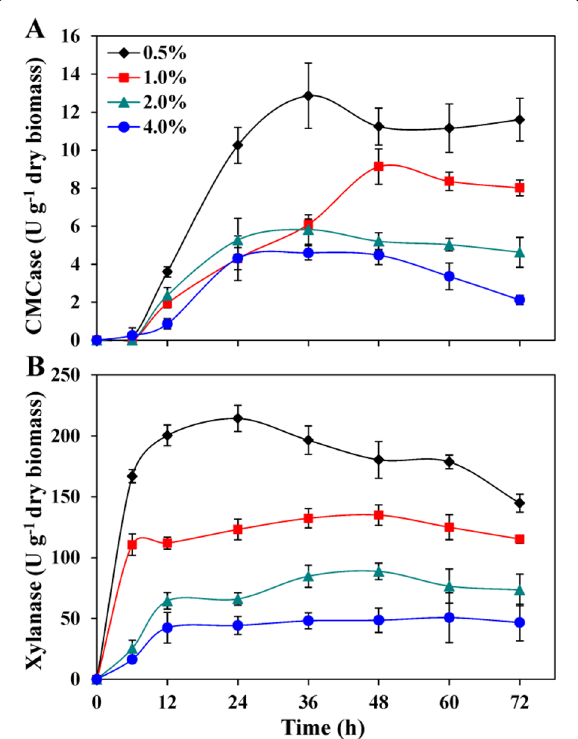
Fig. 3 CMCase ( A ) and xylanase ( B ) activities of Bacillus sp. P3 in MMS broth medium supplemented with different concentrations of corn stover as a substrate. Incubation temperature was 37 °C. Bars indicate the standard deviation ( n =